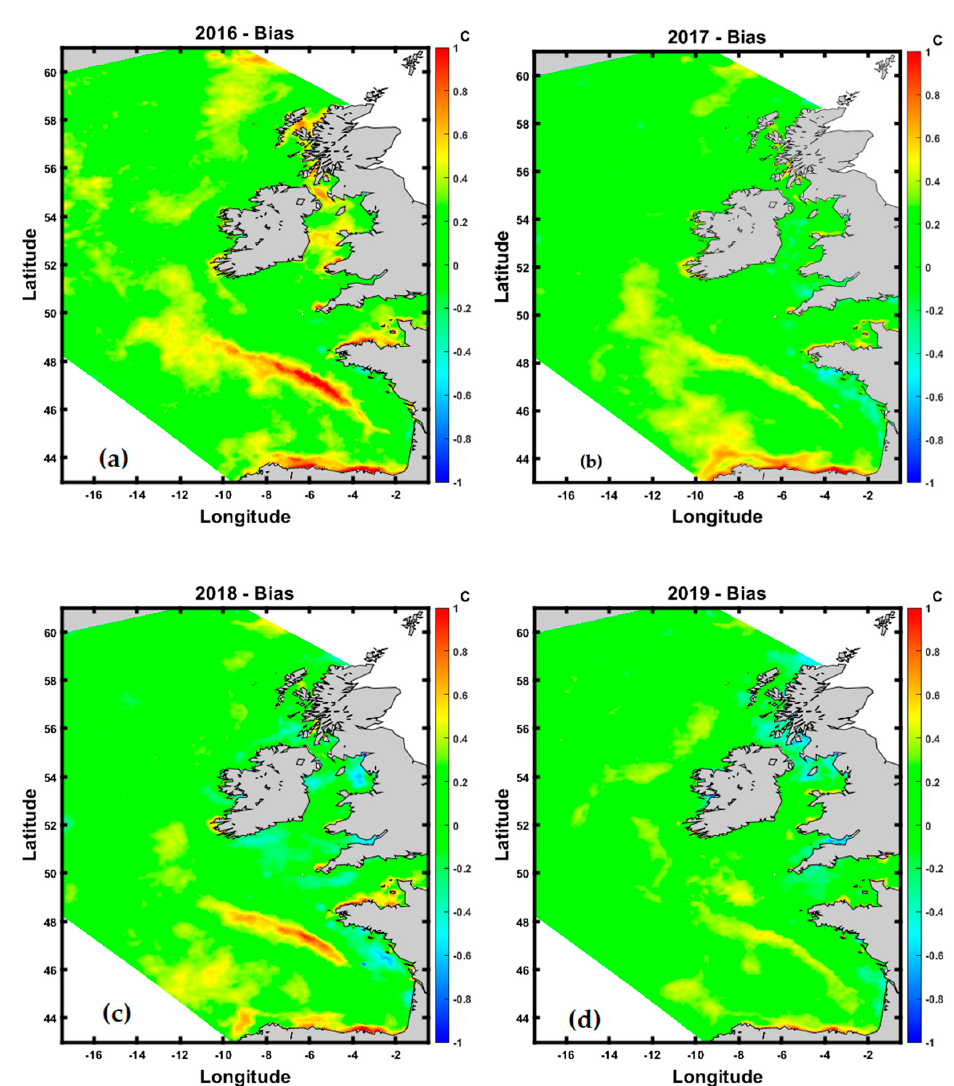
Figure 4. Bias maps between (NEA_ROMS Model-ODYSSEA) satellite data in °C for the model simulation period from 1 January 2016 until 31 December 2019. ( a ) 2016, ( b ) 2017, ( c ) 2018, ( d ) 2019.